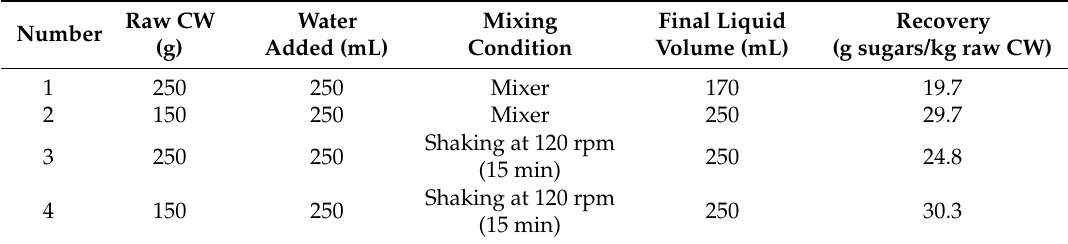
Table 1. Extraction of citrus waste free sugars (CWFS) at room temperature.